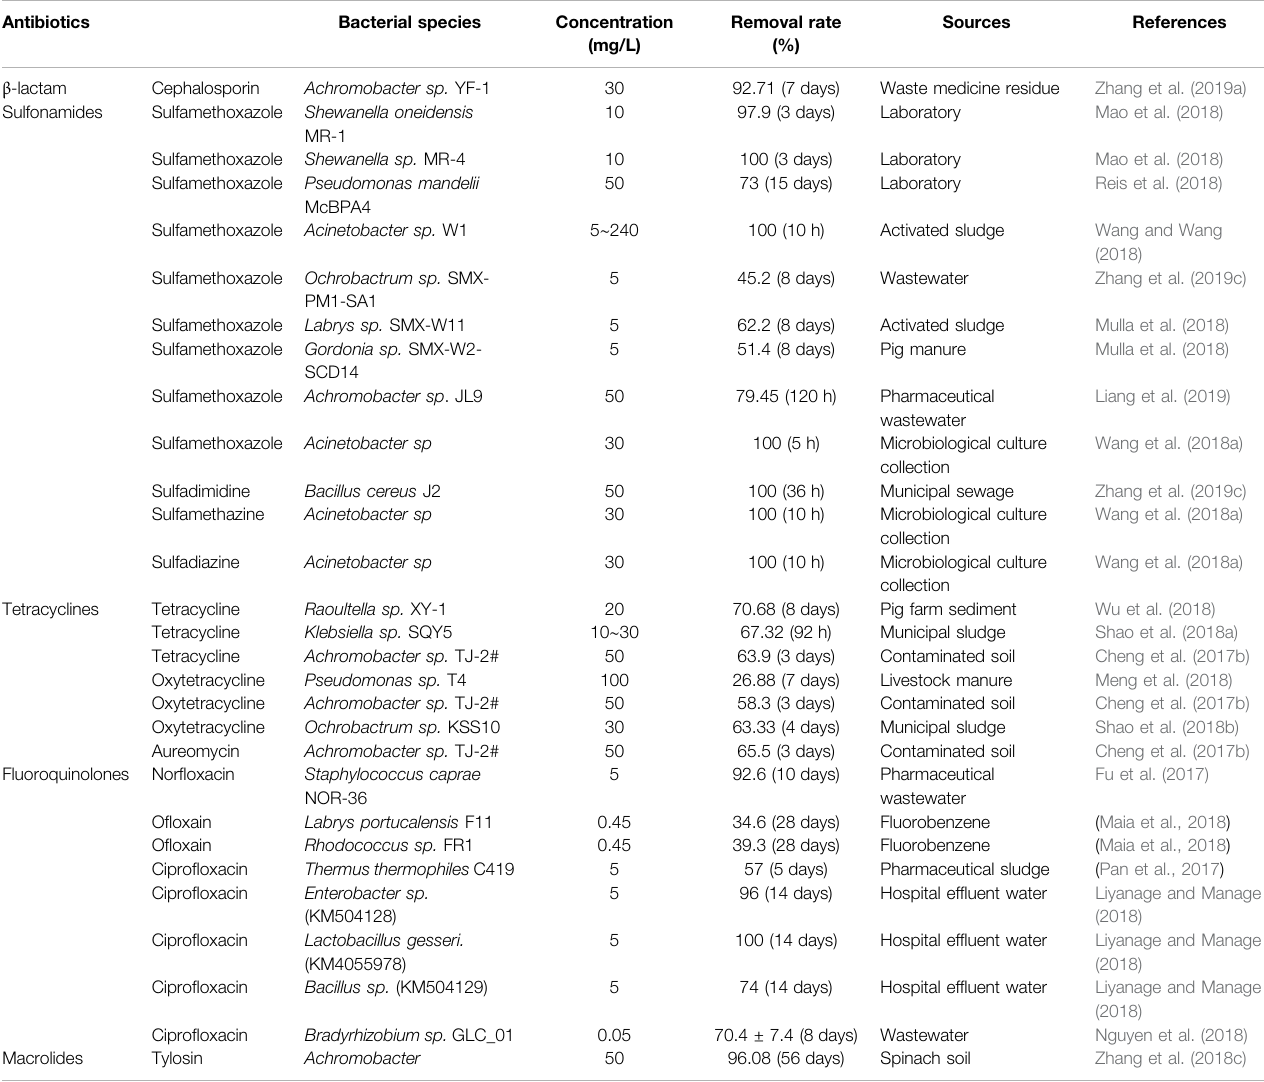
TABLE 8 | Antibiotic-degrading bacterial strains reported in the recent three years. Antibiotics Bacterial